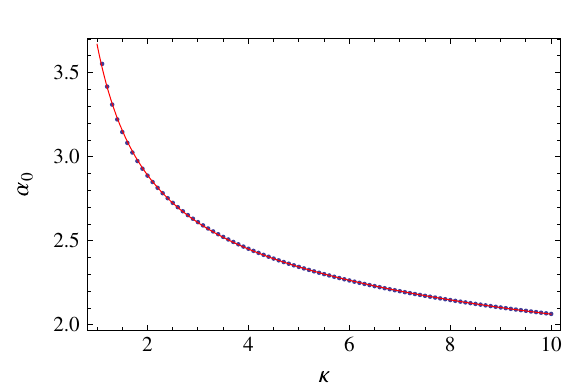
FIG. 14. The initial (cid:7) for the minimum EME emittance. The 0 ¼ 2 : 23 þ red curve is given by the approximate expression (cid:7) 0 1 : 48 =(cid:12) (cid:1) 0 : 04 (cid:12)